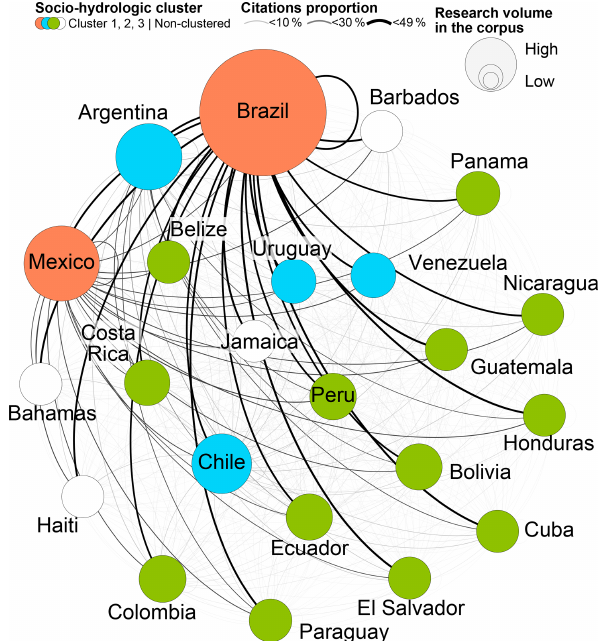
Figure 9. Connectivity between LAC countries, measured by direc- tional citations between articles’ country of study. The direction of each edge is represented by drawing it clockwise from an earlier node to a later